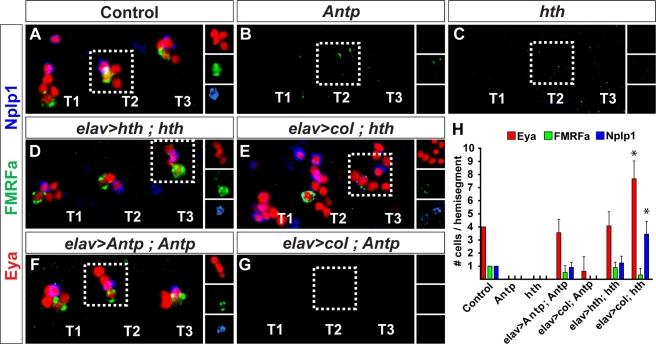

collier is able to rescue homothorax, but not Antp.(A–G) Expression of Eya, FMRFa, and Nplp1 in thoracic segments, at 18 h AEL. Small boxes show the expression of Eya, Nplp1, and proFMRFa in separate panels. (A–C) In control (A), Ap clusters are present, whereas in Antp (B) and hth (C) mutants, expression of Eya, FMRFa, and Nplp1 is lost. (D) Rescue of hth by hth and (F) of Antp by Antp. Both rescues restore Ap-clusters, as evident from the expression of Eya, FMRFa, and Nplp1. In contrast, whereas cross-rescue of hth by col is successful (E), cross-rescue of Antp by col does not restore Ap clusters (G). The extra Ap cluster neurons observed in cross-rescue of hth by col (E) is an effect of ectopic col in the early NB 5–6 lineage when using this Gal4 driver [25]. (H) Quantification of Eya, Nplp1, and FMRFa positive cells/hemisegment (n>20 hemisegments). Asterisk denote significant difference compared to hth rescue, (p<0.01, Student two-tailed test). Genotypes: (A) w1118. (B) Antp25/AntpNs-rvC12. (C) hth5E04/hthDf3R. (D) UAS-hth/+; elav-Gal4,hth5E04/hthDf3R. (E) UAS-col/+; elav-Gal4,hth5E04/hthDf3R. (F) UAS-Antp/+; elav-Gal4,Antp14/AntpNs-rvC12. (G) UAS-col/+; elav-Gal4,Antp14/AntpNs-rvC12.